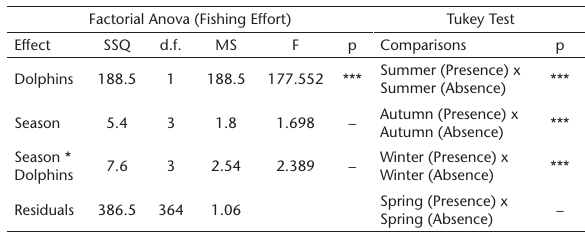
Table 4. Seasonal comparisons of fishing effort and relationships with the presence or absence of dolphins. Factorial ANOVA results indicate sum of squares (SSQ), degrees of freedom (d.f.), average square (MS), F value and Tukey’s